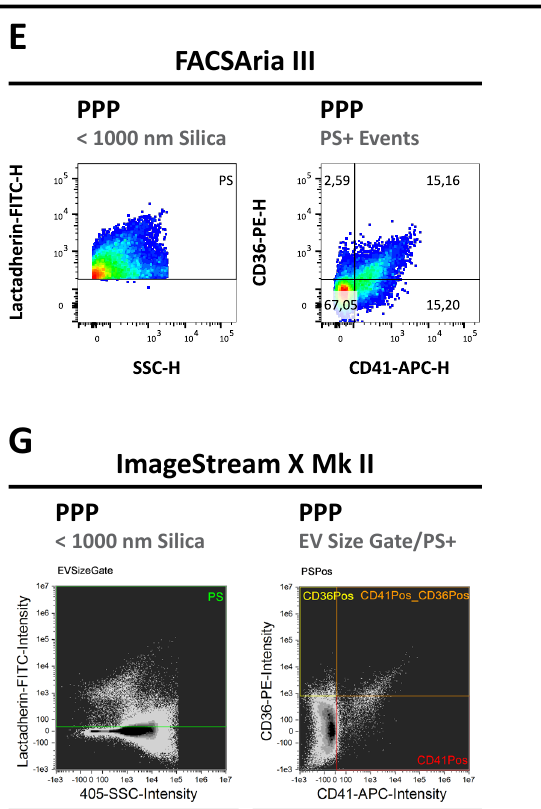
Figure 1. EV-defining gating strategy and depiction of representative data for each of the three flow cytometry platforms. ( A – D ) Schematic depiction of the gating strategy used for defining EV phenotypes in PPP samples. ( A ) First, a size gate was established on the 99th percentile of green fluorescent 1000 nm silica nanospheres (RI 1.42) on FSC/SALS vs. SSC/LALS on FACS Aria III and Apogee A60 Micro-PLUS or ( B ) on 405 nm SSC alone on ImageStream X Mk II. ( C ) Next, on events within the EV size gate in an unlabelled PPP sample, a gate was established on the 99th percentile in the FITC channel to define lactadherin-binding phosphatidylserine (PS)+ events (Apogee A60 Micro-PLUS and ImageStream X Mk II) or set to the triggering threshold value of 200 (FACS Aria III). ( D ) On PS+ events in a PPP sample stained with isotype control antibodies, quadrant gates were established on the 99th percentiles of events in the APC vs PE channels to define different combinations of CD41+/ − and CD36+/ − events, respectively. ( D ) Finally, the sums of CD41+ and CD36+ events were defined by establishing logical OR gates on “CD41+|CD36+ OR CD41+|CD36 − “ and “CD41 − |CD36+ OR CD41+|CD36+”, respectively. ( E – G ) Representative histograms of PS+ events (left) or scatterplots of CD41+/ − |CD36+/ − events (right) for ( E ) FACS Aria III, ( F ) Apogee A60 Micro-PLUS and ( G ) ImageStream X Mk II. EV: Extracellular vesicle; PPP: Platelet poor plasma; PS: Phosphatidylserine; FITC: Fluorescein isothiocyanate; APC: Allophycocyanin; PE: Phycoerythrin; SSC: Side scatter; LALS: Large angle light